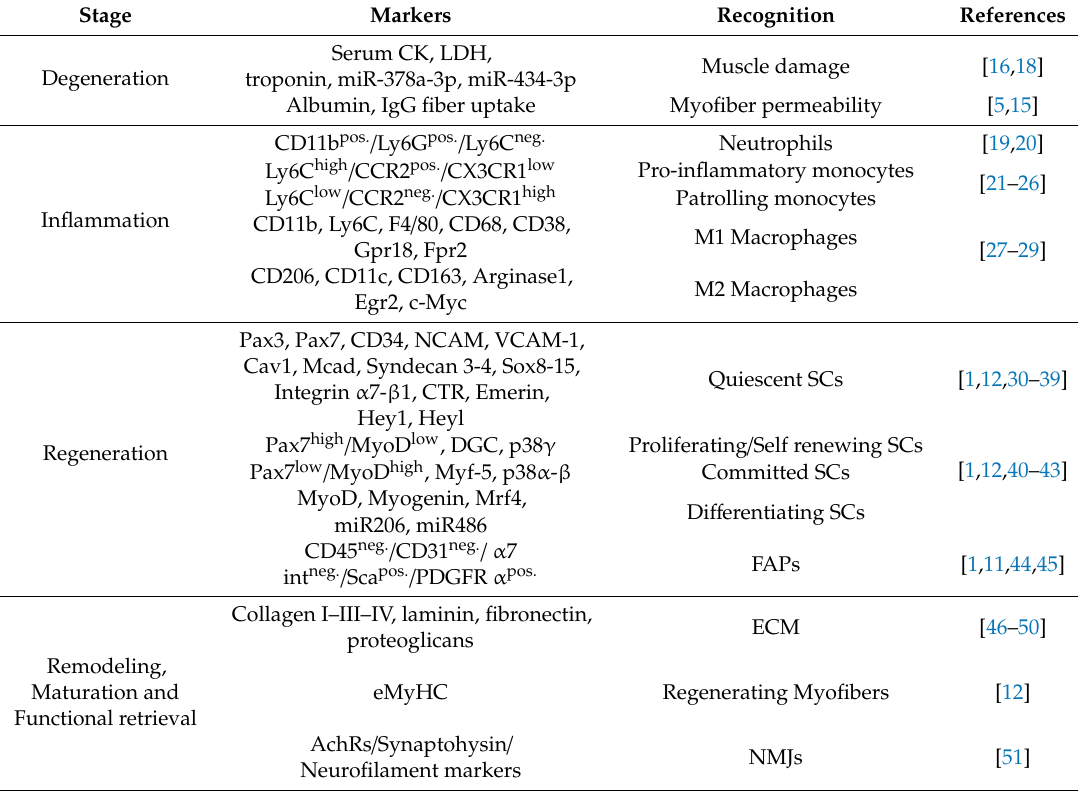
Table 1. Relevant markers of pivotal cellular and molecular actors in the di ff erent stages of muscle